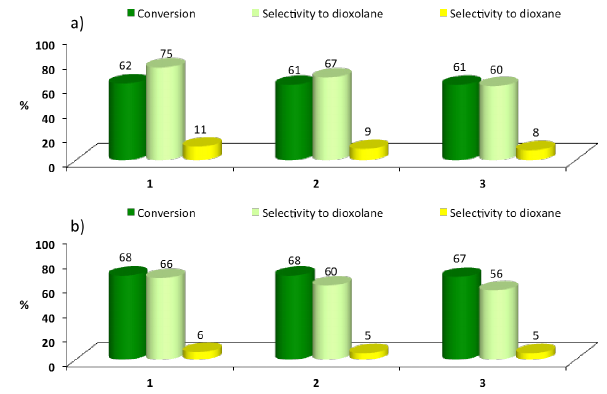
Figure 5: Reuse studies of catalysts a) MK-10-SC and b)